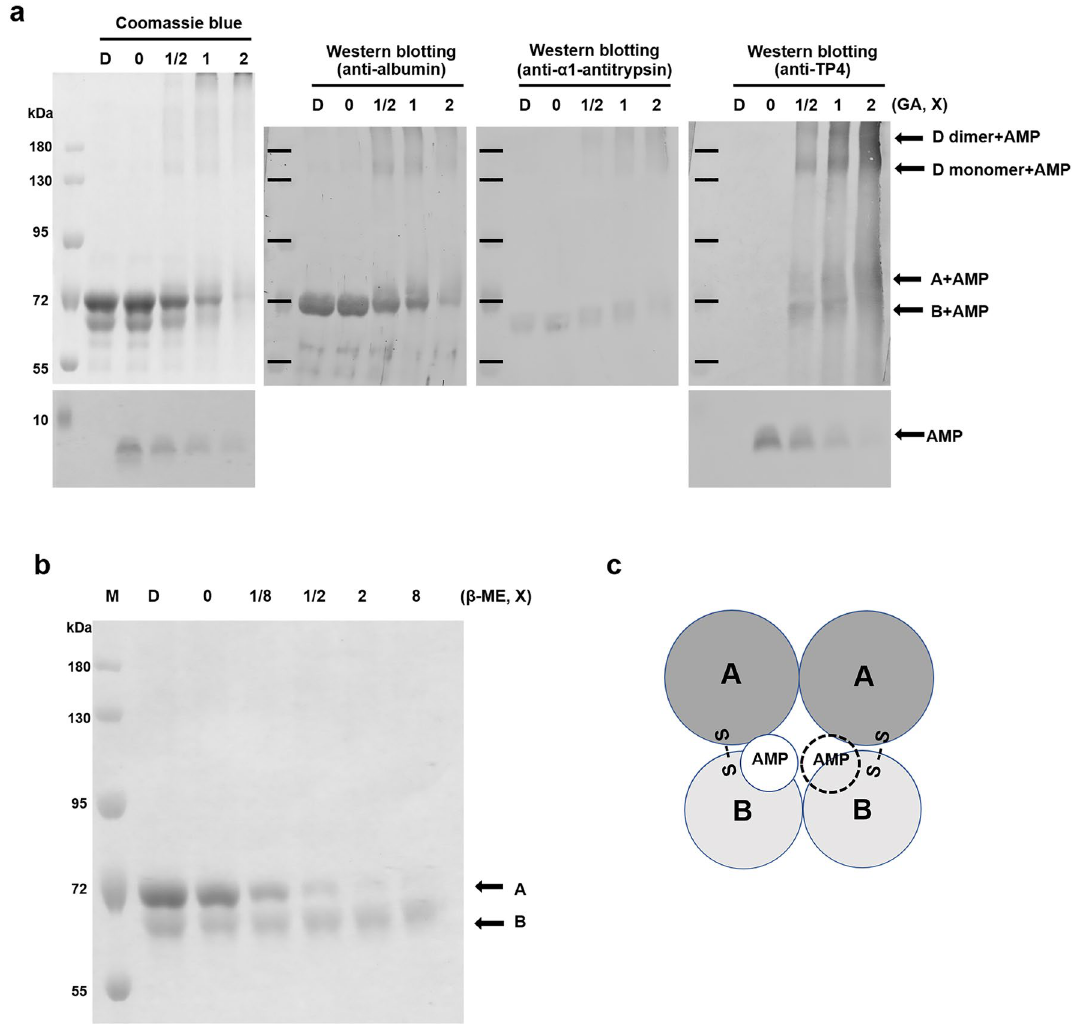
Figure 6. Binding of TP4-A12I,A15I peptides to the albumin/α1-antitrypsin complex. ( a ) Binding of TP4- A12I,A15I peptides to protein D. The AMP-protein D complexes were cross-linked with glutaraldehyde (GA), separated by 8% or 15% reduced SDS-PAGE, stained by Coomassie blue and detected by Western blotting using antibodies raised against albumin, α1-antitrypsin and TP4, respectively. 1X represents 0.00625% GA. ( b ) Binding of TP4-A12I,A15I peptides to the α1-antitrypsin subunit. The protein D was pulled down by immobilized biotinylated TP4-A12I,A15I on Streptavidin beads. The retained proteins after β-mercaptoethanol (β-ME) wash were analyzed by 8% reduced SDS-PAGE and Coomassie blue staining. 1X represents 0.25% β-ME. ( c ) Model for the interaction between AMP and protein D. The active complex is composed of two identical protein D and each subunit is composed of protein A (albumin) and protein B (α1-antitrypsin) linked by disulfide